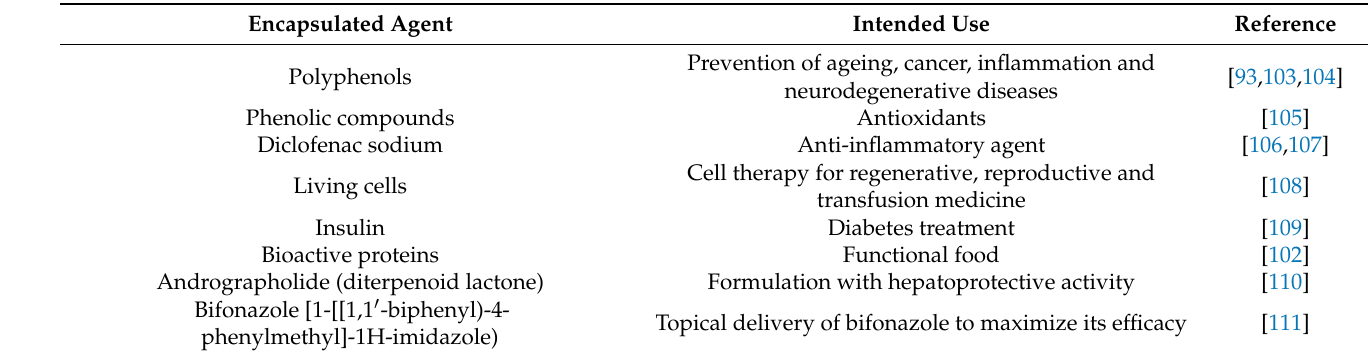
Table 3. Some published uses of multiple emulsions for encapsulation.